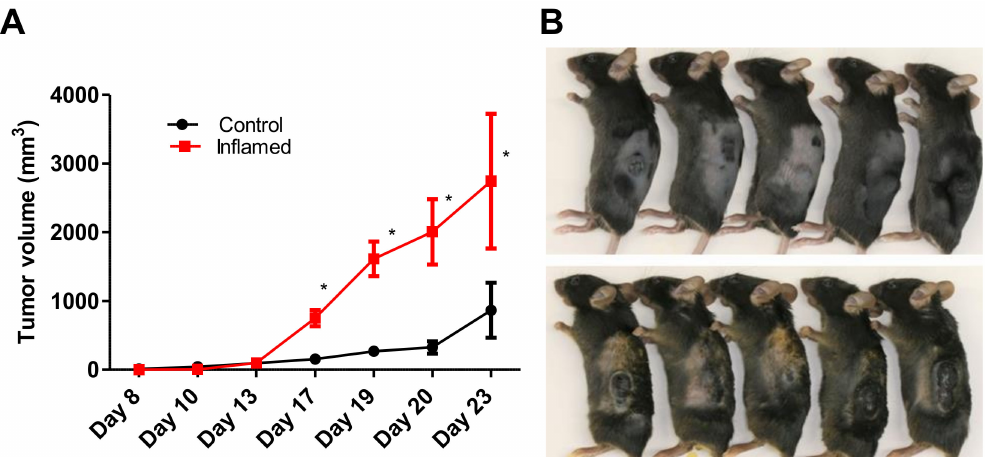
Figure 2. Chronic inflammation significantly accelerates murine melanoma progression. Control mice and inflamed mice were inoculated with B16F10 cells (1 × 10 5 cells/100 µ L of PBS) into the back skin. ( A ) Tumor volume was measured approximately every two days after B16F10 inoculation and was calculated as described in Materials and Methods. t -test; * p < 0.05. ( B ) Representative images of melanoma are shown. Upper panel: Control mice. Lower panel: Inflamed mice. Each group consisted of eight mice. Representative data of three independent experiments are